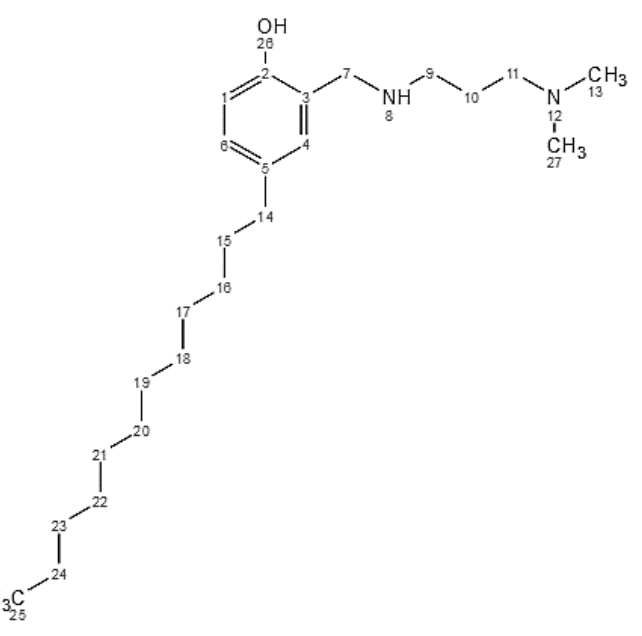
Figure 8. Structure of 2-(((3-dimethylaminopropyl)amino)methyl)-4-dodecylphenol with numbered carbon atoms.